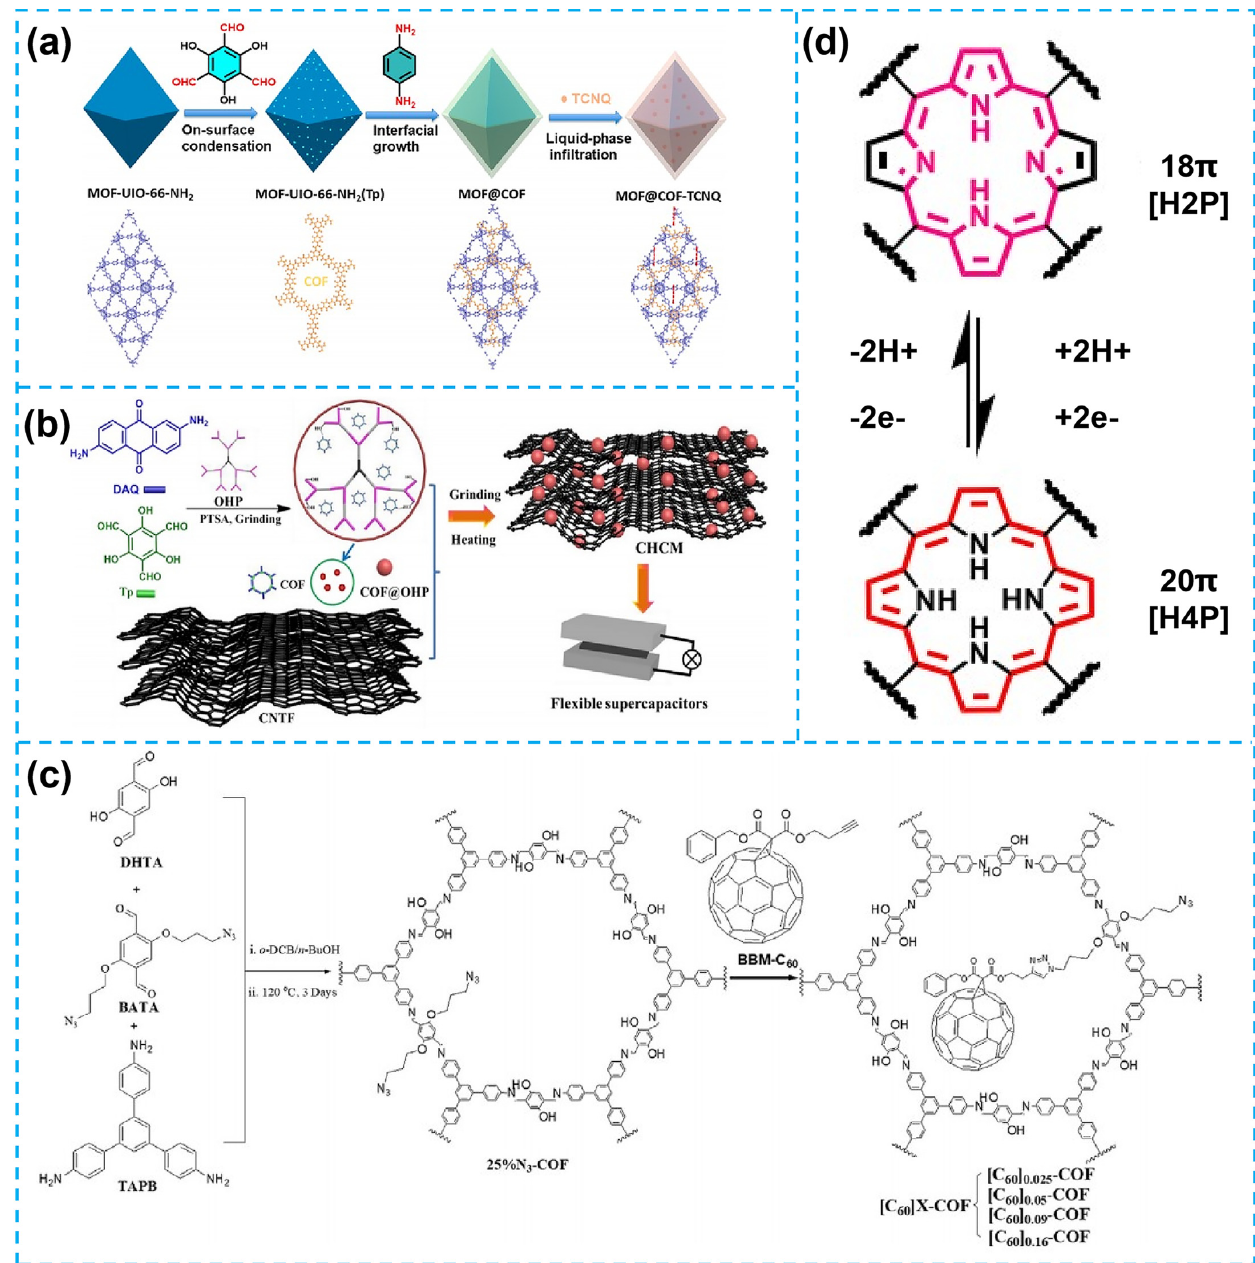
Figure 5. ( a ) Schematic of the synthesis route for MOF@COF − TCNQ hybrids. Reprinted